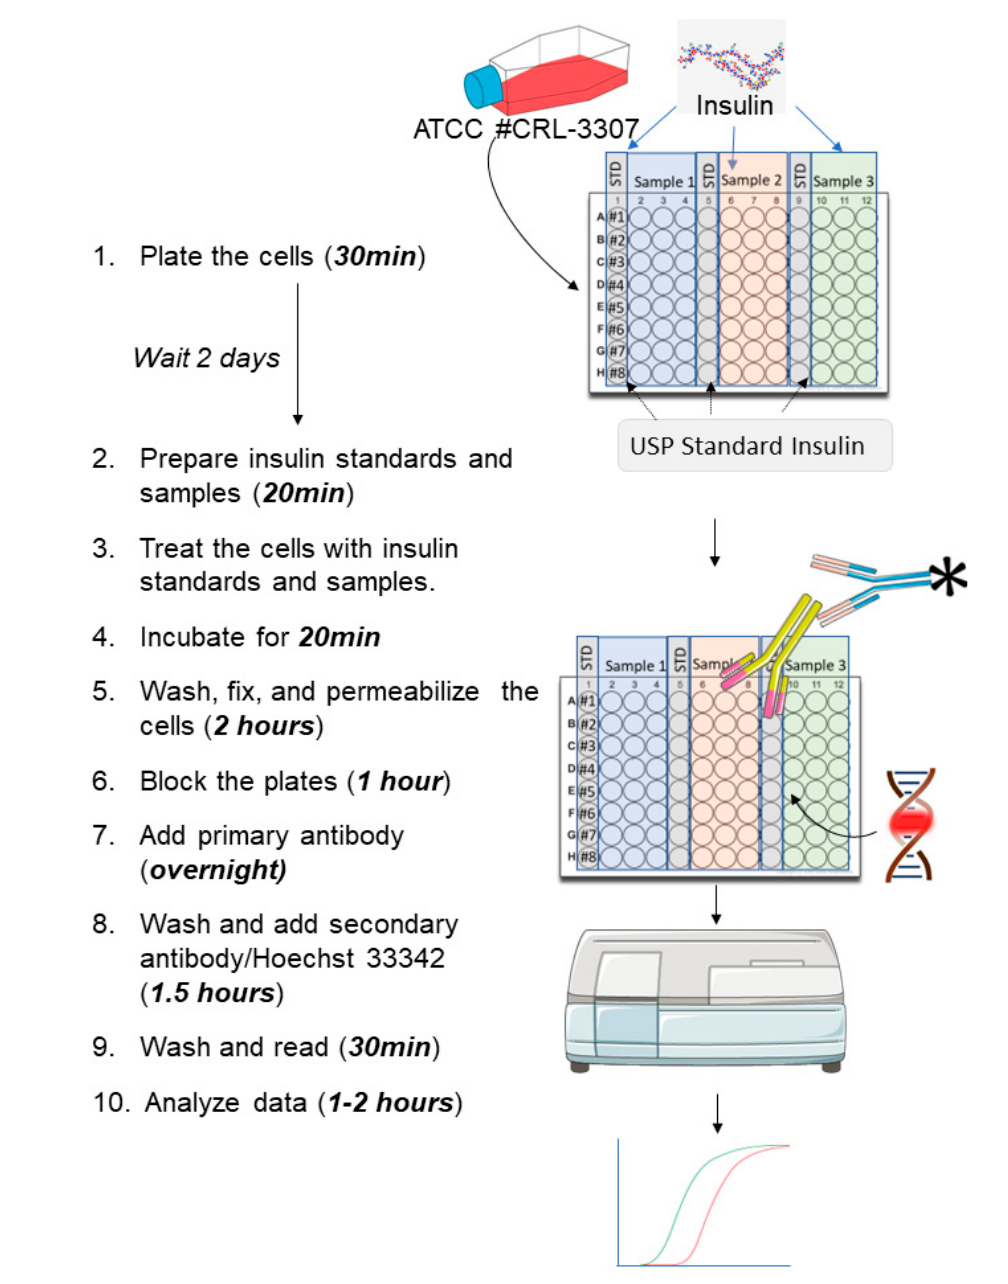
Figure 1. Experimental design of the in-cell western assay.